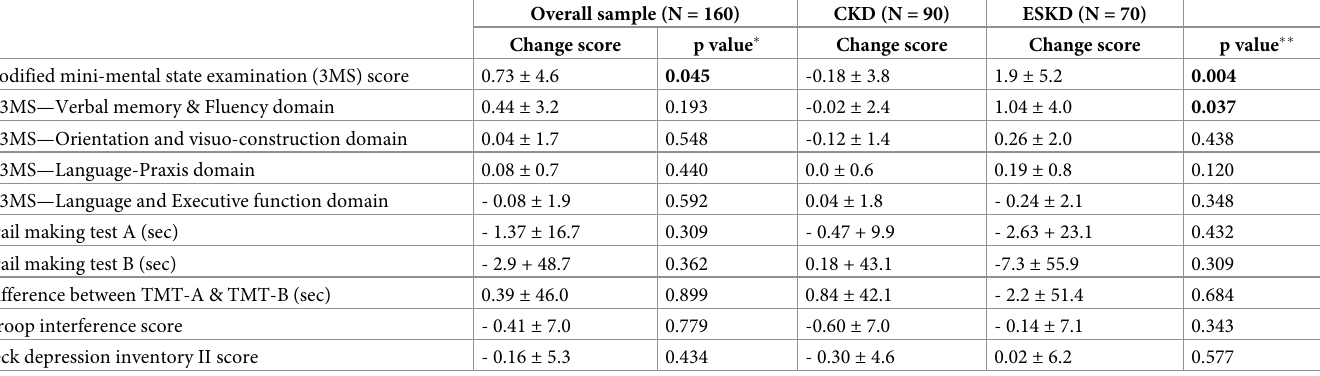
Table 4. Changes in scores of cognitive function and depression between baseline and follow-up for the overall sample and comparison of change scores between non-dialysis CKD and ESKD subgroups.